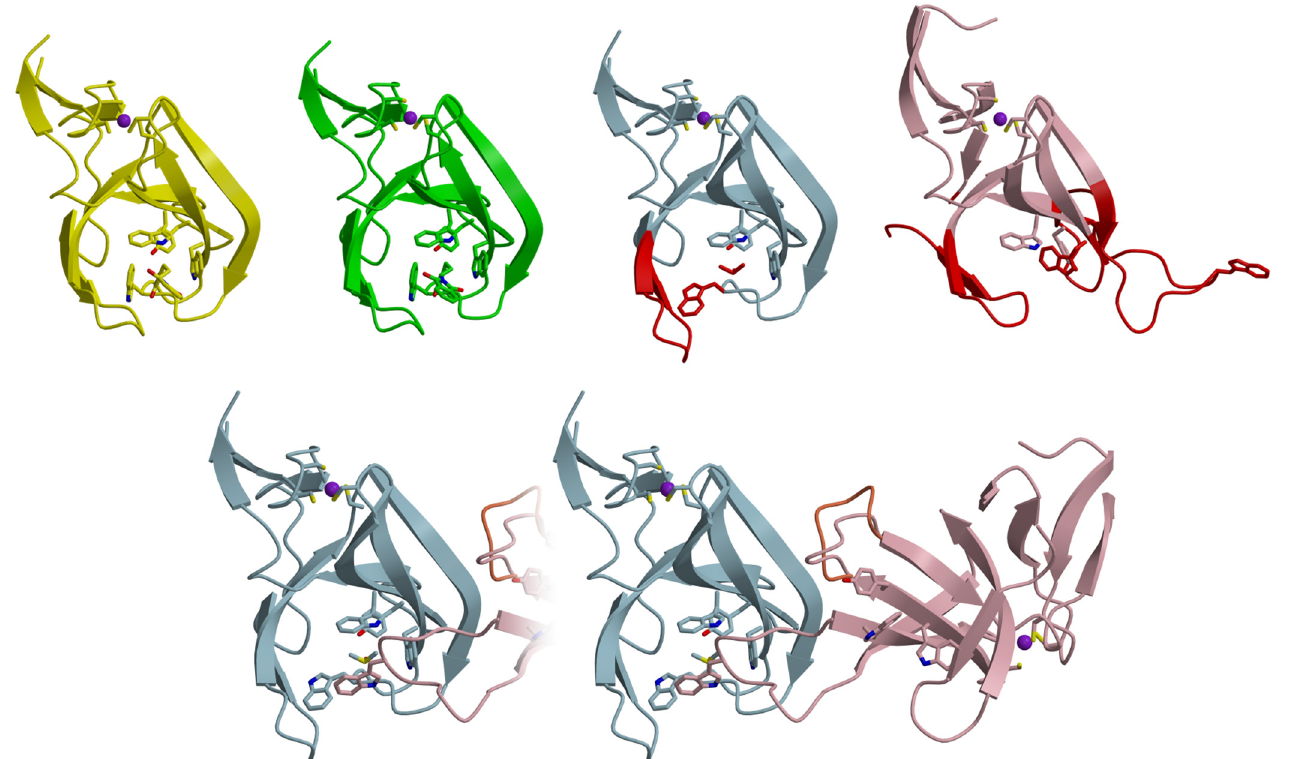
Fig 3. MsCI4 in different conformations in the hexagonal crystal form. Top: The 4 monomers in the ASU are found in three different conformations. The yellow and green monomer are in the known thalidomide-bound conformation. The blue monomer is in a conformation similar to the thalidomide-bound one, but its binding site is occupied by a DMSO molecule, which is accompanied with a displacement of one tryptophan of the aromatic cage (red). The pink monomer is in an overall distorted conformation and does not have the aromatic cage formed: the β 3- β 4 hairpin has another strand register, one of the tryptophans is flipped, and another tryptophan is displaced by 30 Å (all in red). A second conformation of the 3 rd flexible region is displayed in another shade of red. Bottom: The blue and the pink monomers form an intertwined dimer, in which the displaced tryptophan of the pink monomer completes the aromatic cage of the blue one, trapping a DMSO molecule in a binding site with a modified architecture. Here, the second conformation of the 3 rd flexible region of the pink monomer is in orange.